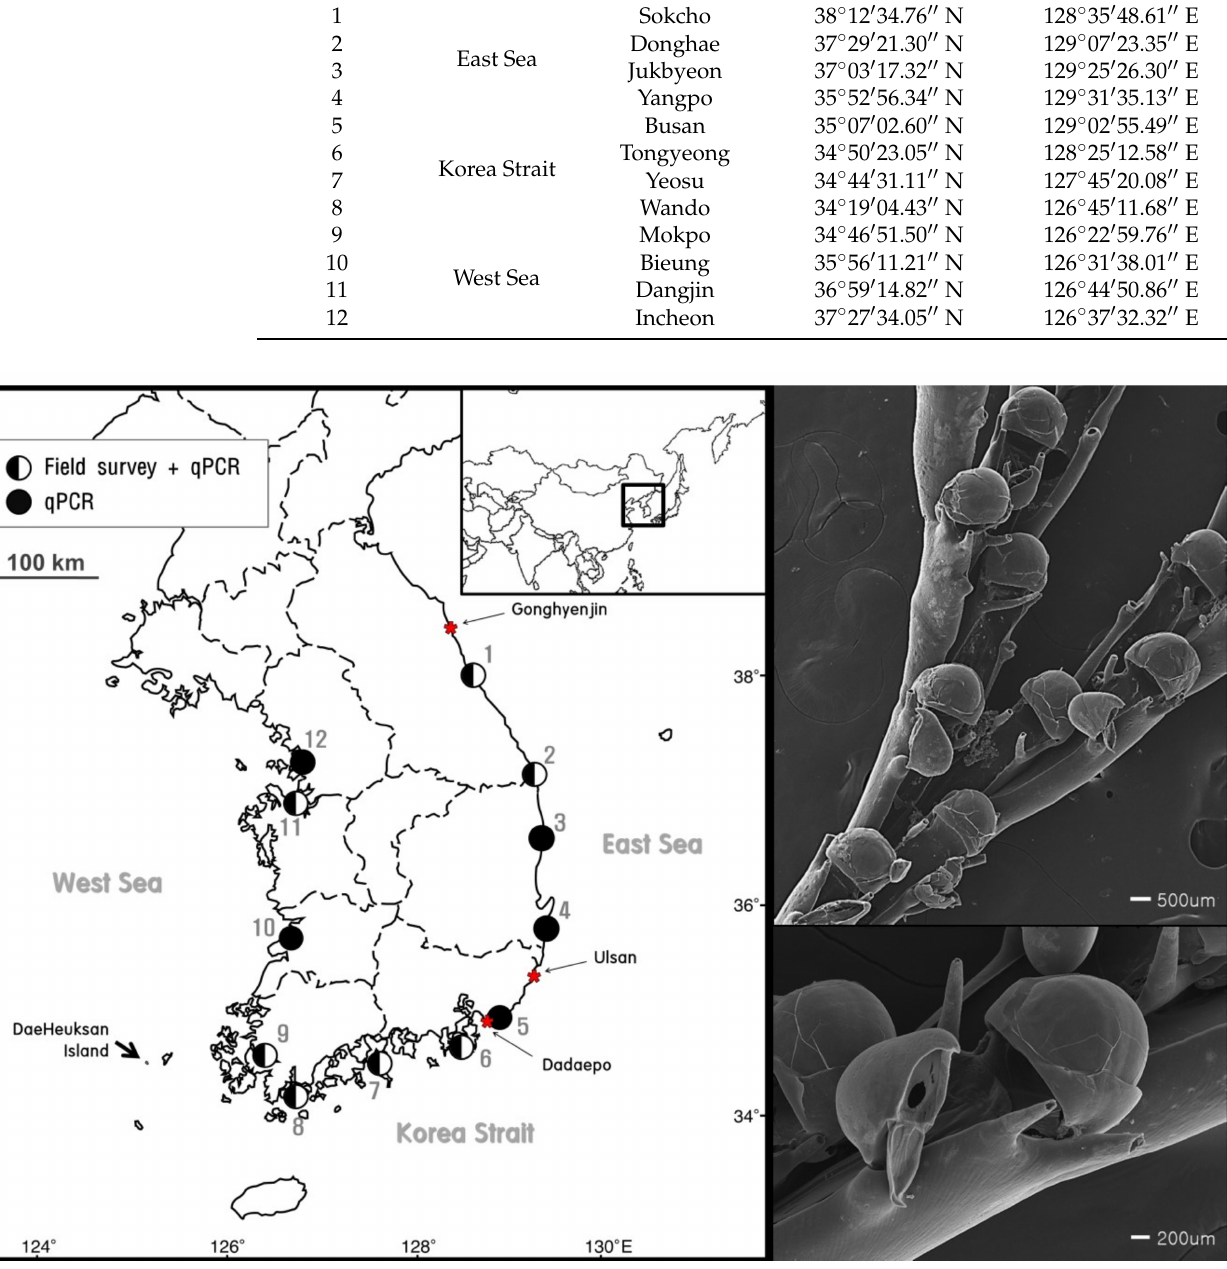
Figure 1. Sites of B. californica detection by field survey with qPCR analysis ( ) and qPCR analysis alone ( ). The star ( ) indicates the sampling sites for the molecular analysis and species analysis ( left ). Scanning electron microscope (SEM) images of B. californica ( right